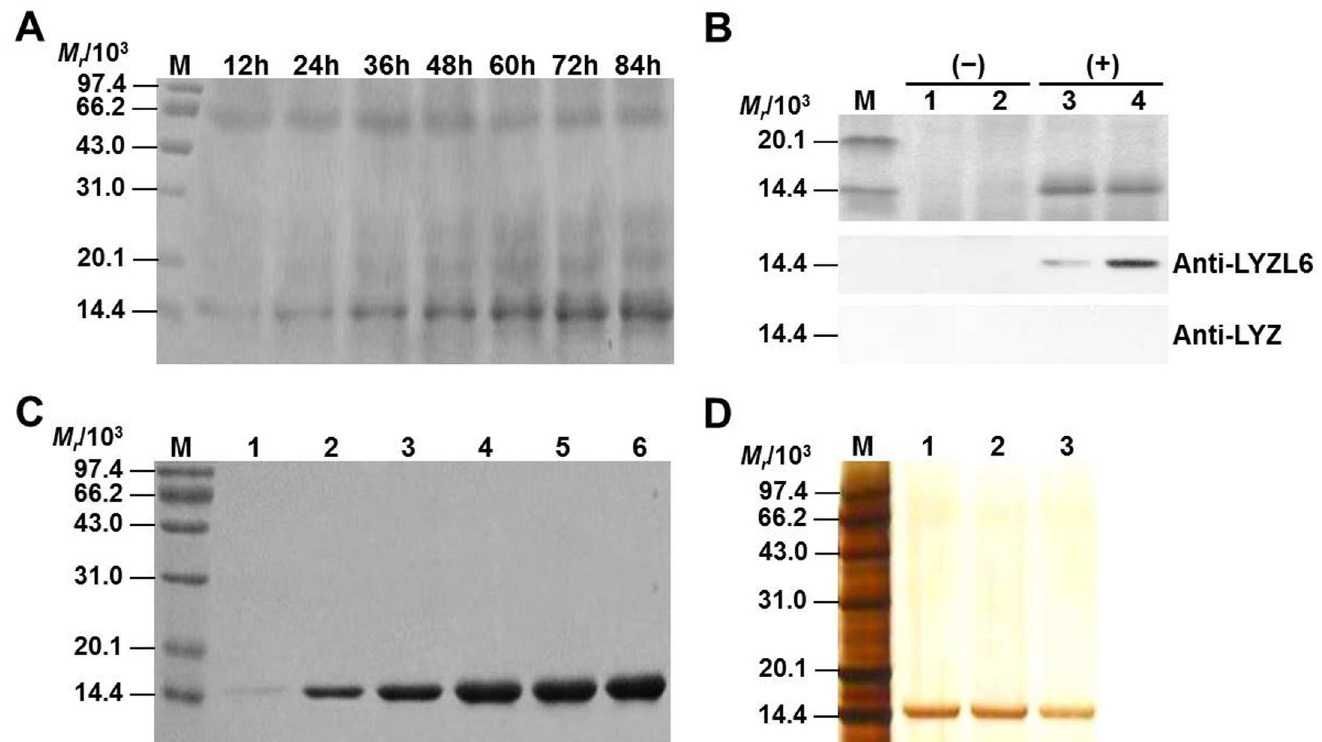
Fig 4. Identification of rLYZL6 expressedin P . pastoris . A) SDS–PAGE of LYZL6 expressionat varioustime points after methanolinduction.Lane M: MW marker. Supernatant protein (~10 μ g per lane) was loaded.B) Western blot analysisof the fermentation supernatant. Lane M: MW marker; Lane 1–2: fermentation supernatantfrom un-transformed yeast; Lane 3–4: fermentation supernatant from recombinant yeast. C) SDS–PAGE of fractions collected by chitin affinity chromatography. The amount of rLYZL6 loadedwas 0.1 μ g (lane 1), 0.5 μ g (lane 2), 1 μ g (lane 3), 2 μ g (lane 4–6). D) Silver stained SDS– PAGE of samplescollectedthrough size exclusion chromatography steps. Lane M: MW marker; Lane 1–3: rLYZL6 (~0.5 μ g per lane). The samples were obtainedfrom three separate experiments.